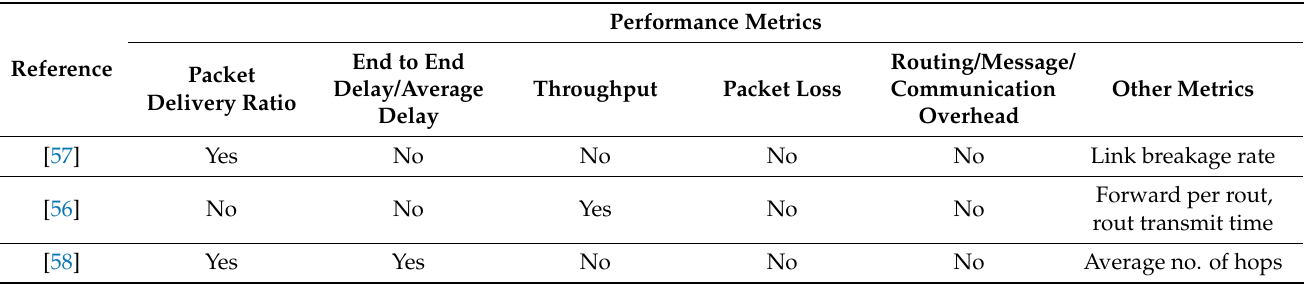
Table 19. Performance metrics of urban scenario with streets-based routing